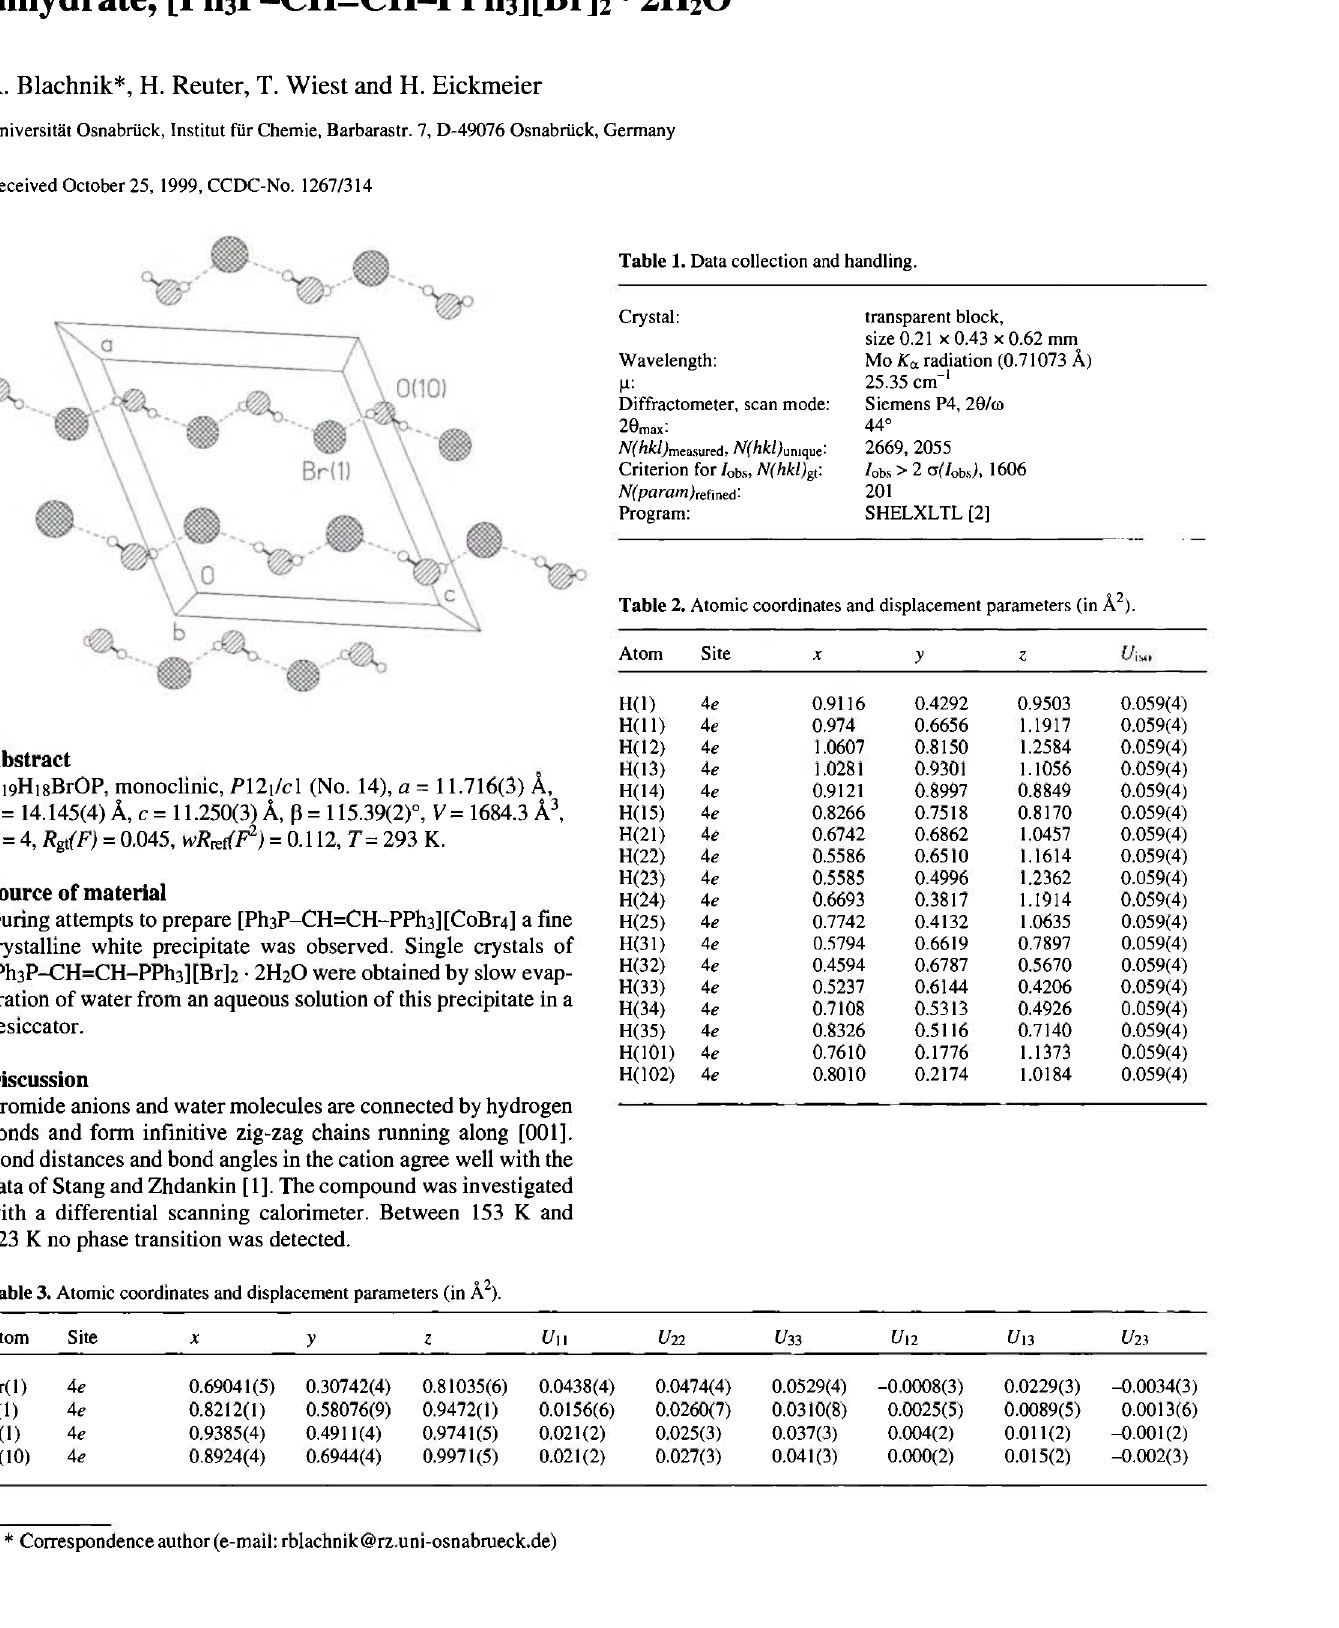
Table 1. Data collection and handling.